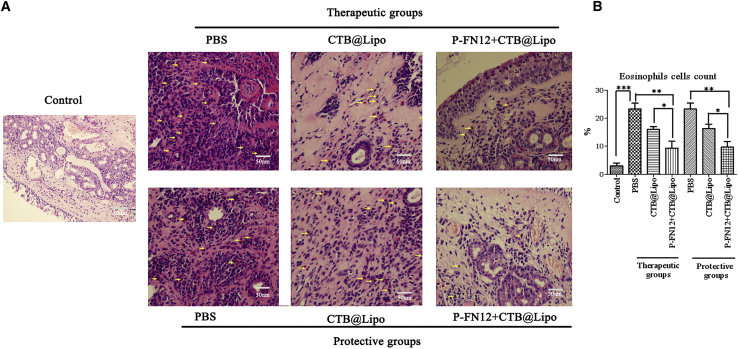
Effects of P-FN12 + CTB@Lipo on the Filtration of Eosinophils into Nasal Mucosa of AR Rats(A) Infiltration of eosinophils (arrows) in the nasal mucosa of rats (n = 5) (H&E, 400×). (B) The proportion of eosinophil cell counts in the nasal mucosa of each group in the field. *p < 0.05; **p < 0.01; ***p < 0.001.